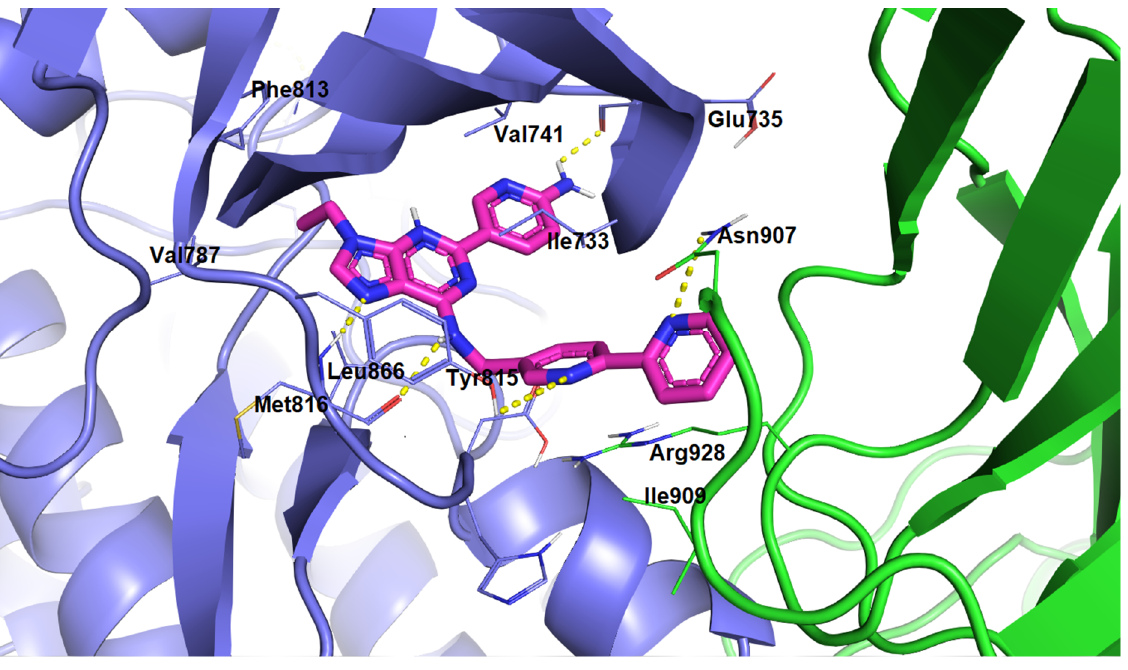
Figure 5. Docking result of 30d in CDK12–DDB1 complex. Docking was performed based on the X-ray co-crystal structure of R-CR8 (pdb id: 6td3), and visualized using Pymol2.5 software (Schrödinger, New York, NY, USA). CDK12, DDB1, and 30d are colored in cyan, green, and purple, respectively. The labeled residues are predicted to interact with 30d . Predicted hydrogen bonds are highlighted in yellow dotted lines.